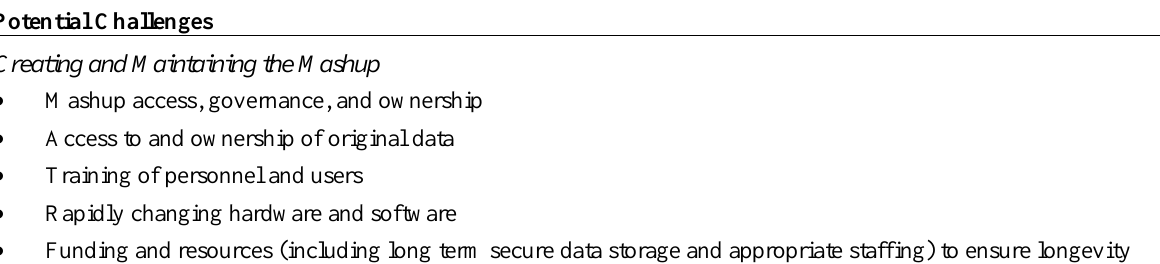
Table 2. Potential challenges for and with data